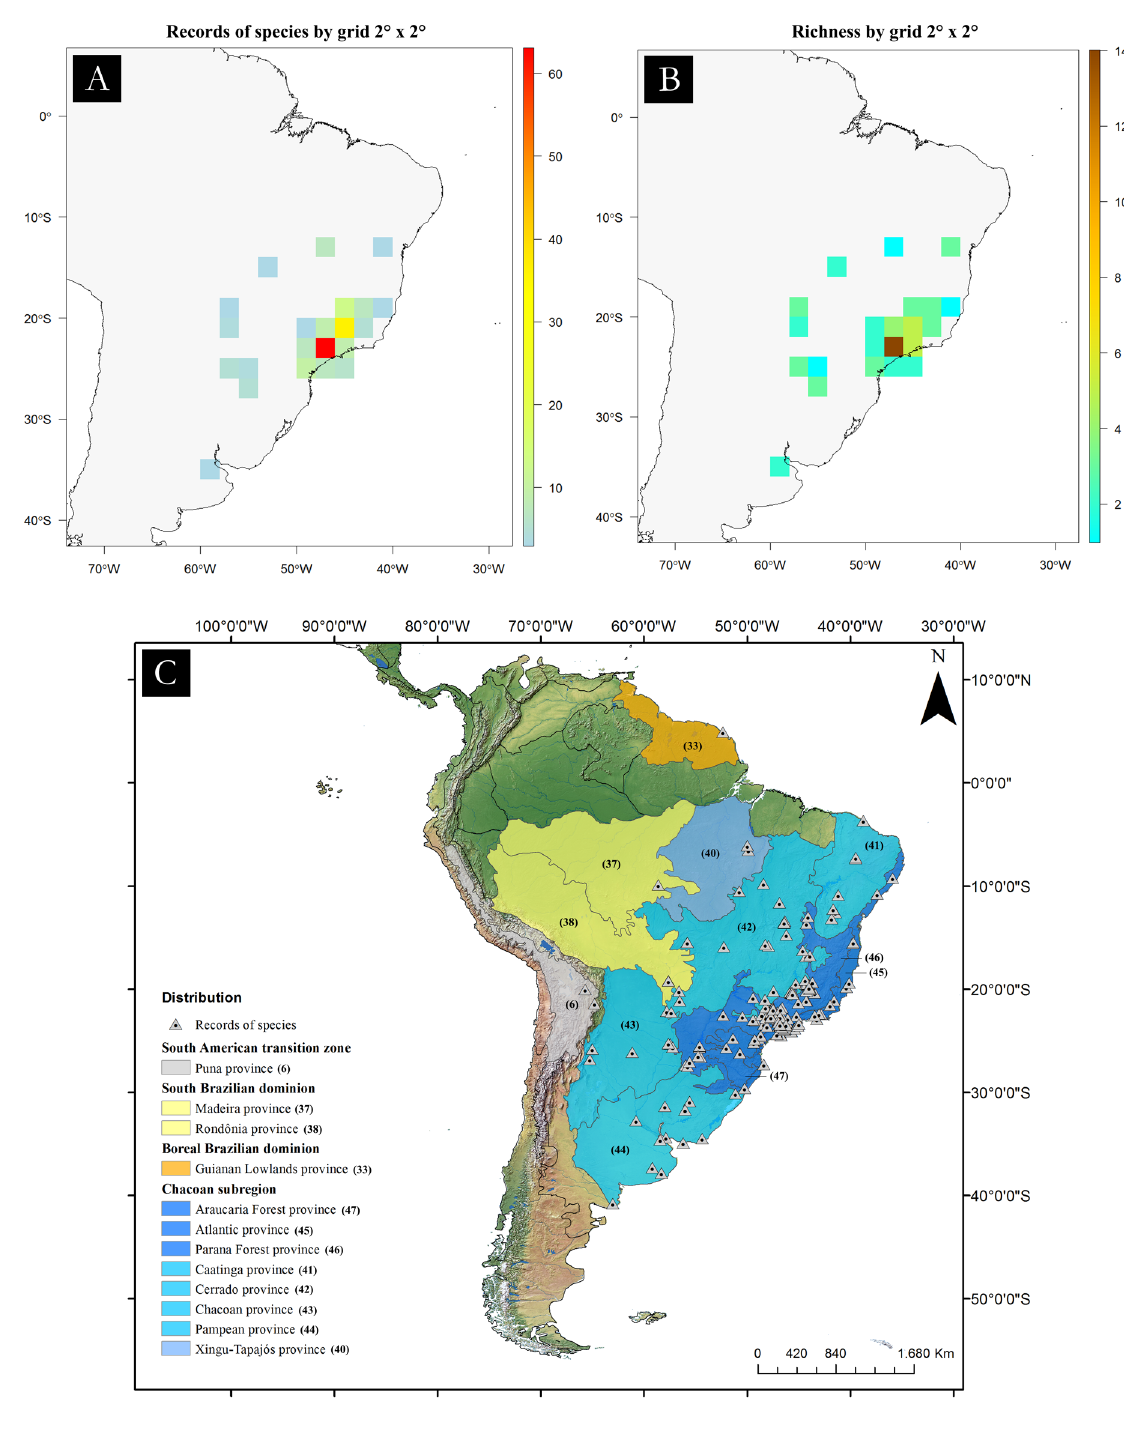
Fig. 13. Distribution maps of Pseudonannolene Silvestri, 1895 . A . Records of species by grid 2° × 2°. B . Richness by grid 2° × 2°. C . Distribution of the genus in South America. The colored areas represent the biogeographical division of the Neotropical region (Morrone 2014; Löwenberg-Neto 2014). Grids containing only one record of a single species are omitted in the maps A and